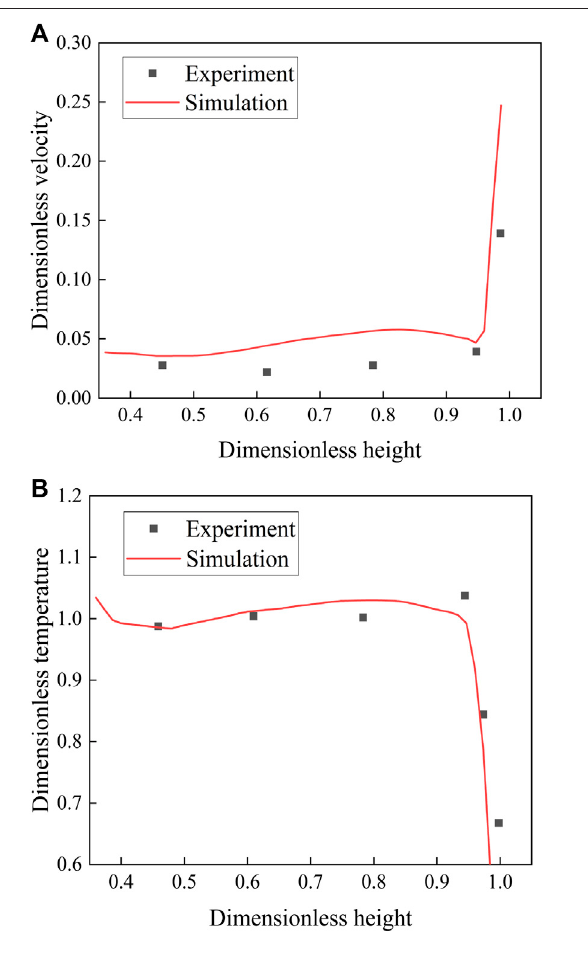
FIGURE 4 | Comparison between the simulated results and experimental results from Srebric and Chen (Srebric and Chen, 2002): (A) variationofdimensionlessvelocity; (B)